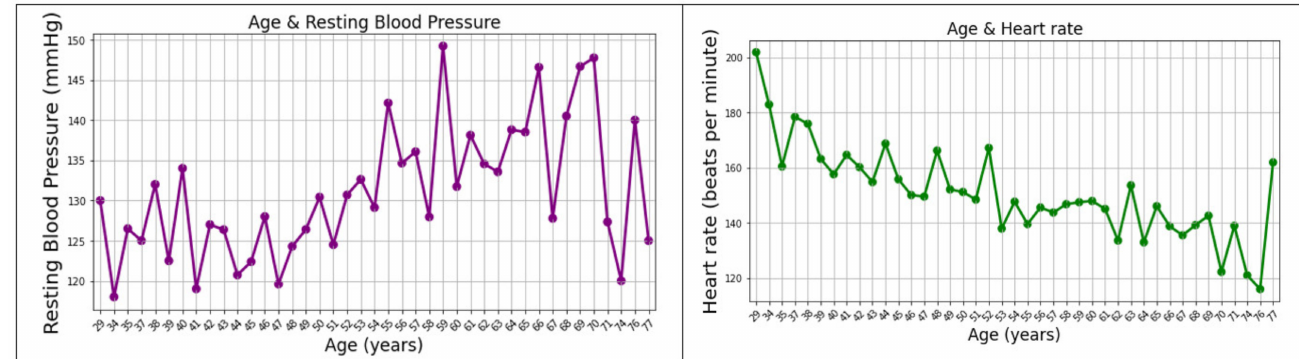
Figure 4. Age and resting blood pressure plot ( left ); age and heart rate plot ( right